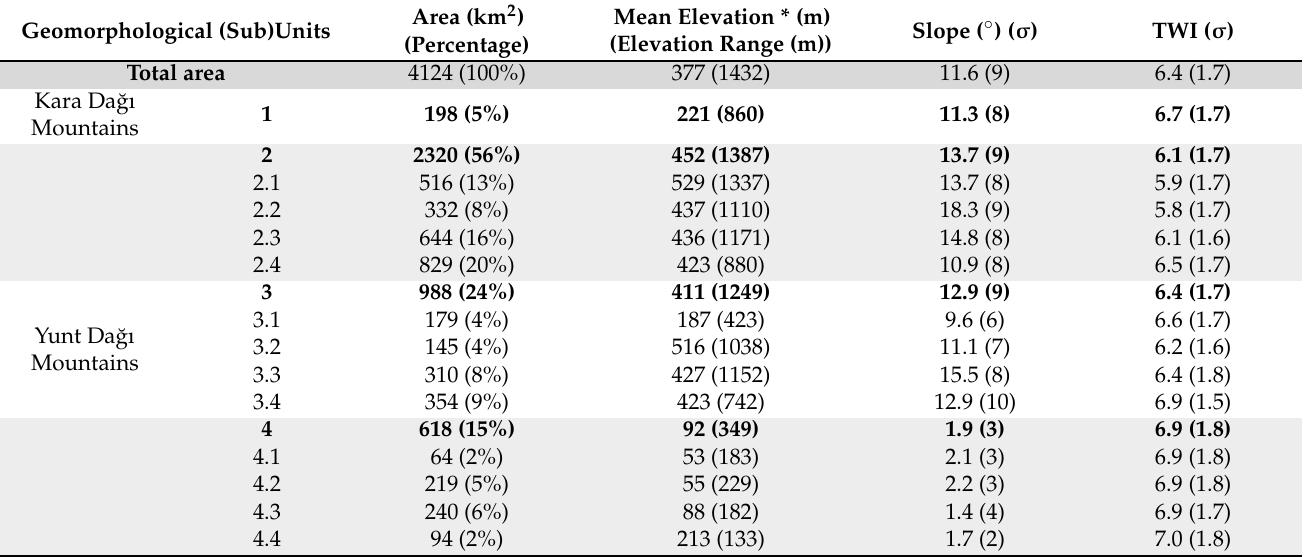
Table 2. Geomorphological parameters in the four geomorphological units and their subunits of the study area (see Figure 1C for the